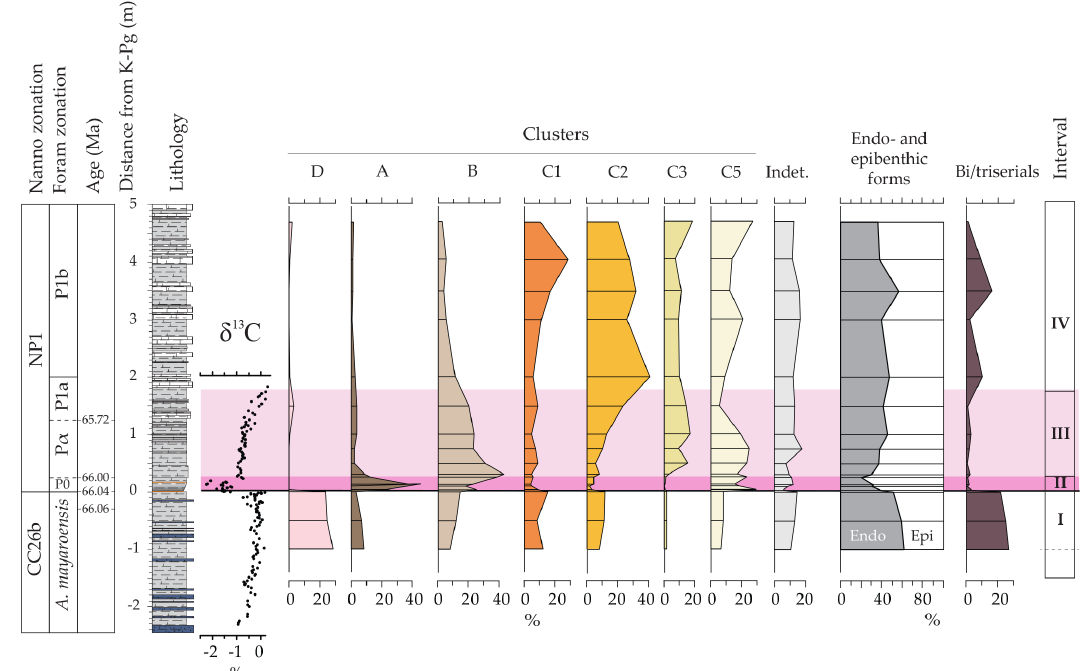
Figure 6. Relative abundances of the four main clusters of benthic foraminiferal taxa (>125µm), relative abundances of epibenthic and endobenthic forms, and relative abundance of bi-/triserial benthic taxa.